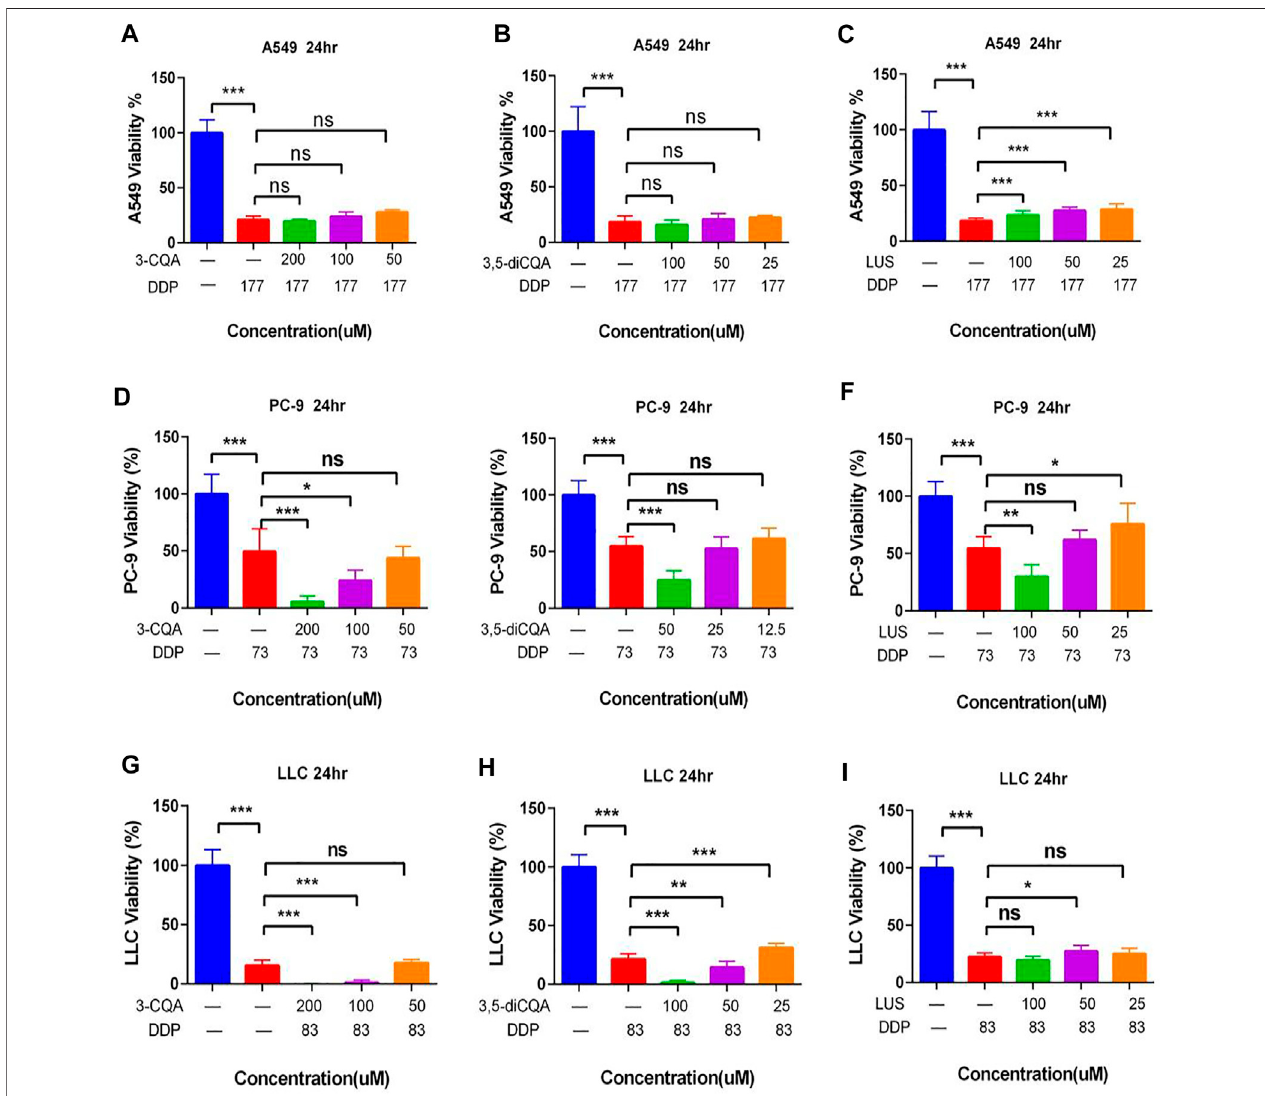
FIGURE 8 | Effects of different compound on the antitumor activity of DDP in vitro . (A – C) Dosage of chlorogenic acid (3-CQA), 3,5-dicaffeoylquinic acid (3,5- diCQA), or luteoloside (LUS) on the antitumor activity of DDP in A549 cells. (D – F) Dosage of chlorogenic acid (3-CQA), 3,5-dicaffeoylquinic acid (3,5-diCQA), or luteoloside (LUS) on the antitumor activity of DDP in PC9 cells. (G – I) Dosage of chlorogenic acid (3-CQA), 3,5-dicaffeoylquinic acid (3,5-diCQA), or luteoloside (LUS) on the antitumor activity of DDP in LLC cells. Error bars are represented as mean ± SEM. The p values were determined by Student ’ s t test (* p < 0.05, ** p < .01, *** p <